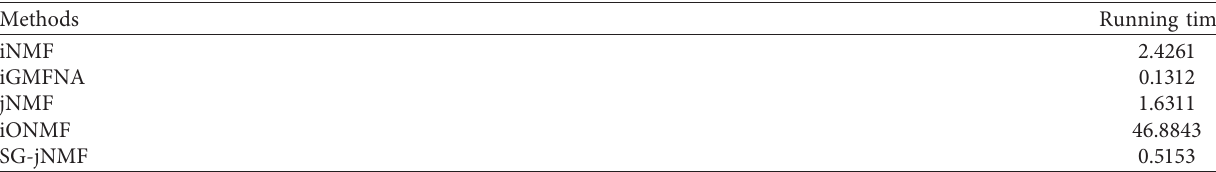
Figure 2: Comparison of convergence of five methods on PAAD dataset. Table 1: Running time on PAAD.